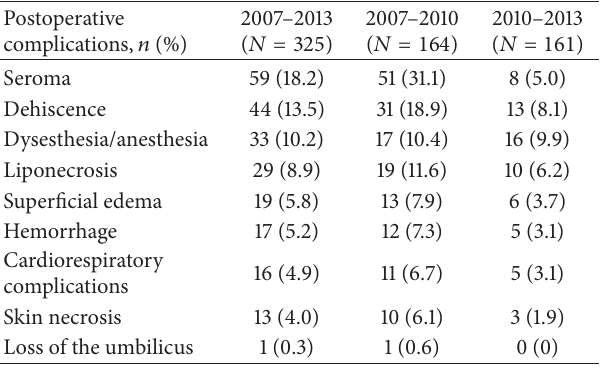
Table 4: Postoperative complications for the 325 patients during the study period associated with